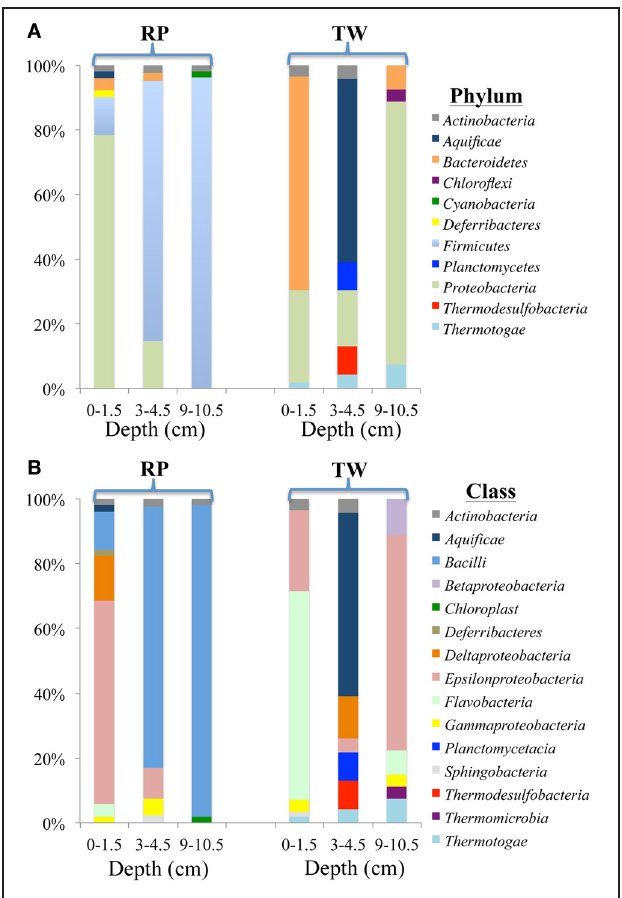
FIGURE 4 | Diversity and distribution of clones within bacterial phylum (A) and class (B) clone libraries for three depths of RP and TW sediment layers investigated in this study. Each color represents the percentages of each taxon in the total respective clone library, as determined by screening of full length 16S rRNA gene sequences. Depths are 0–1.5, 3–4.5, and 9–10.5cm, and indicated at the bottom of site